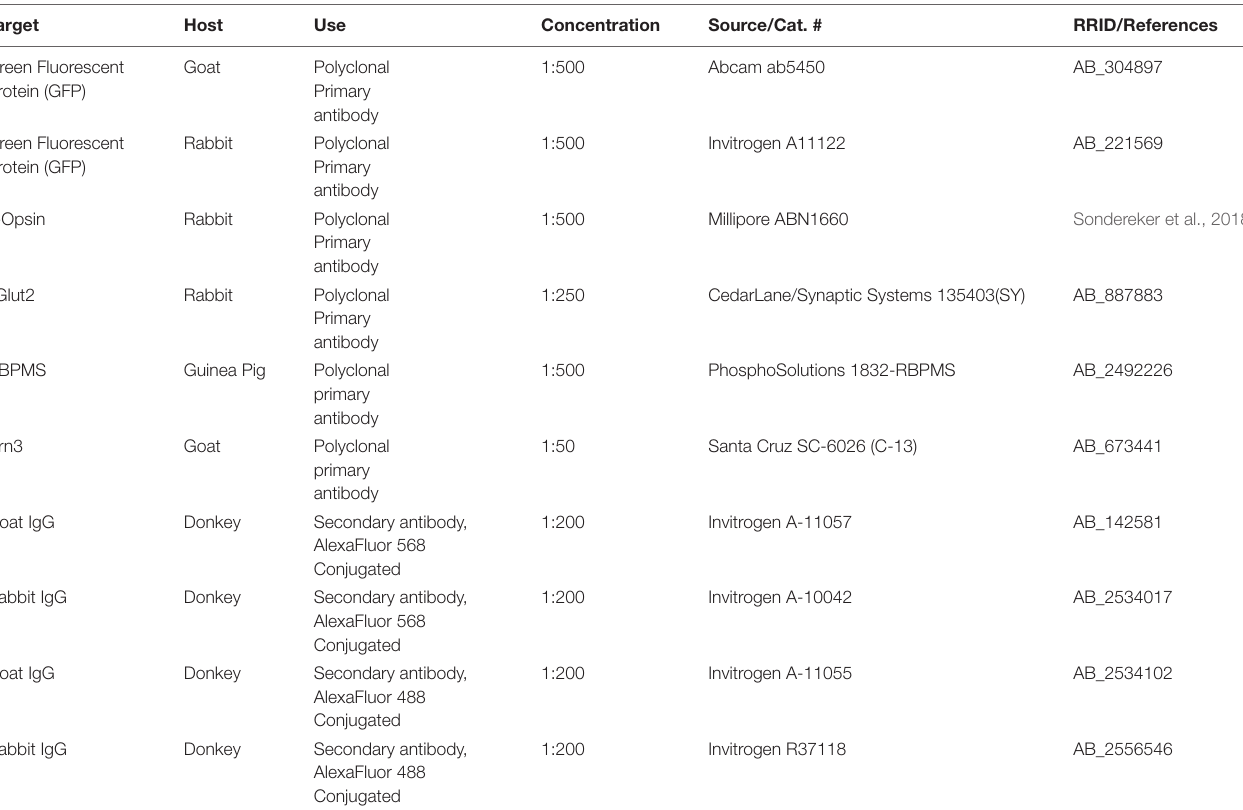
TABLE 1 | Antibodies used in this